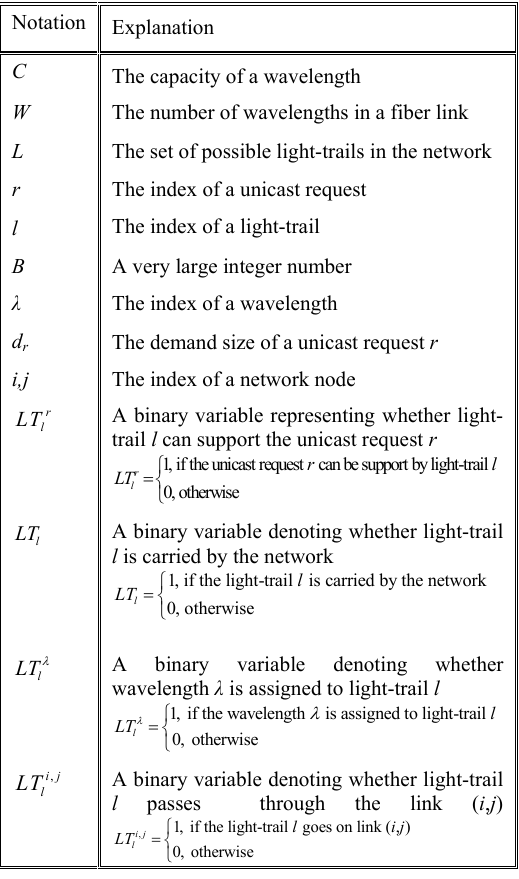
TABLE 3. Notations used in ILP